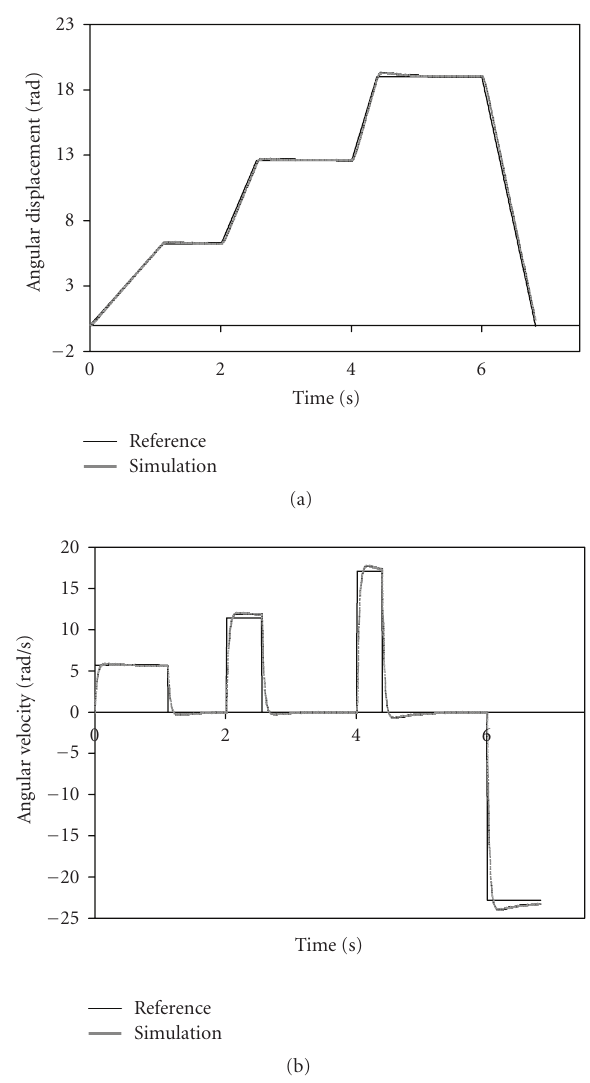
Figure 3: Simulation results for trapezoidal motion II.